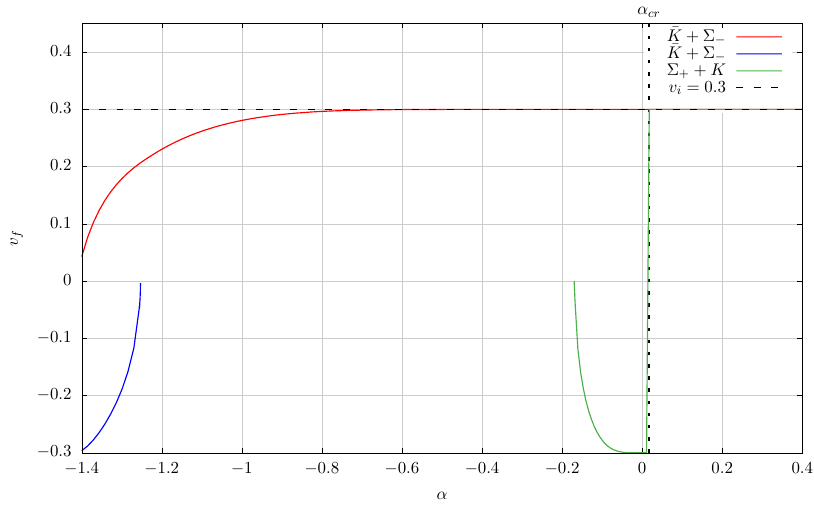
Figure 22 . Velocities of free defects propagating after impurity-defect type